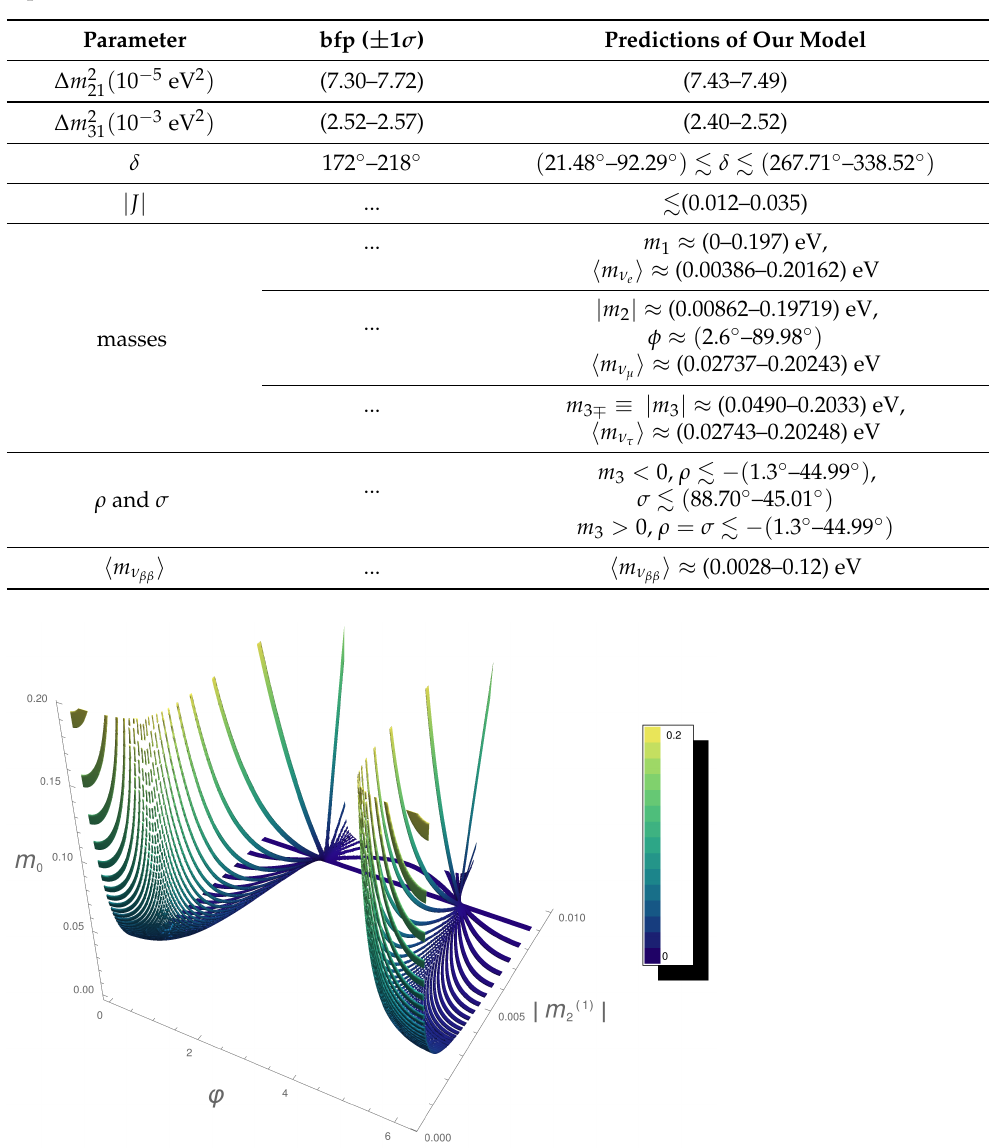
Table 2. The available experimental data for neutrinos for the case of normal mass hierarchy and the predictions of our model. These predictions are obtained from our parameters as shown in Equation(24).